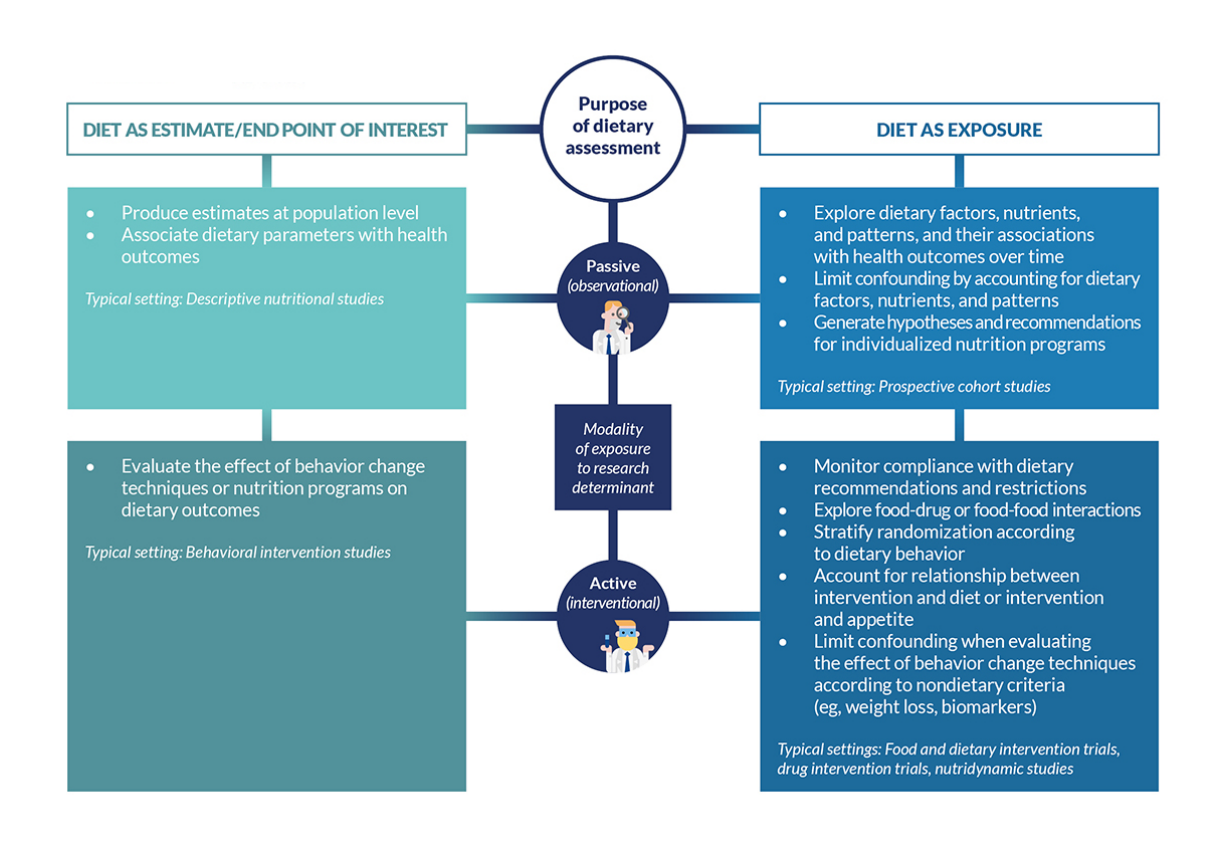
Figure 1. Relevant frameworks for using dietary assessment tools in human